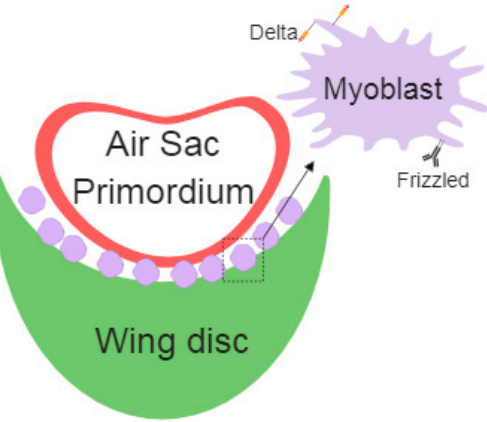
Figure 2. Schematic representation of air sac primordium (ASP), wing disc epithelial cells, and myoblasts cells with specific Delta- or Frizzled-cytonemes.